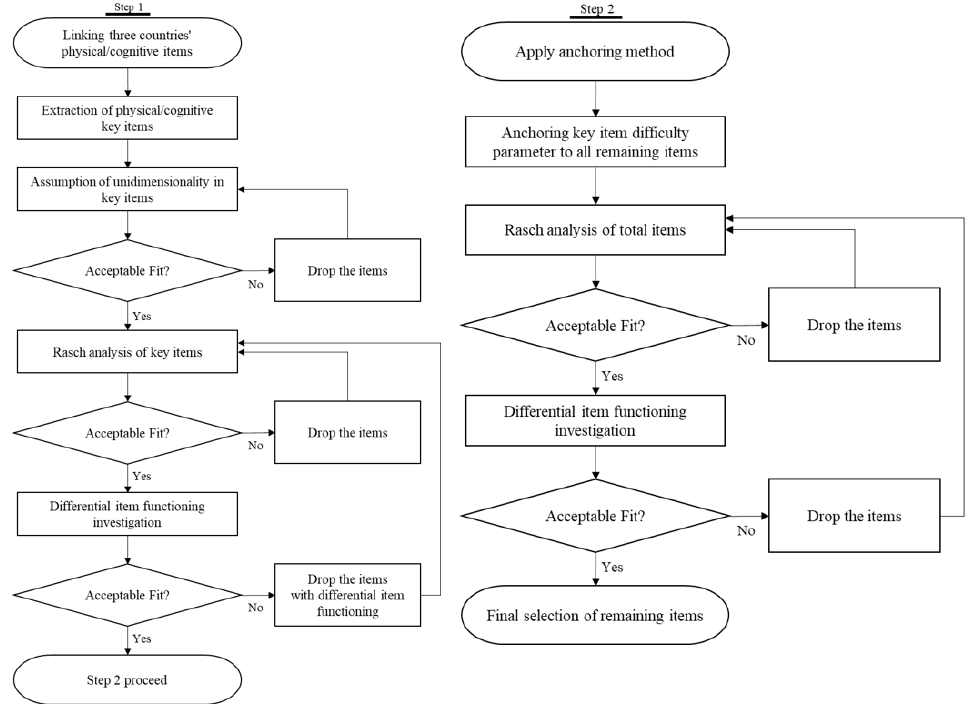
Figure 1. Flow chart of this study.